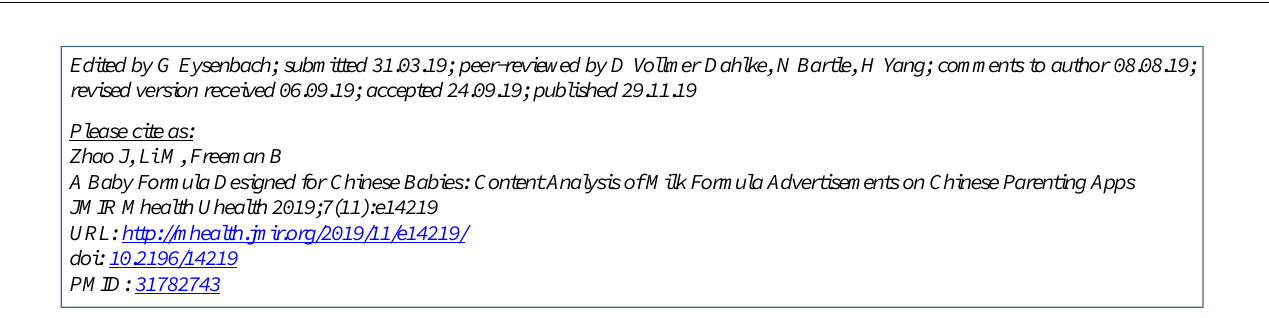
Code: The International Code of Marketing of Breast Milk